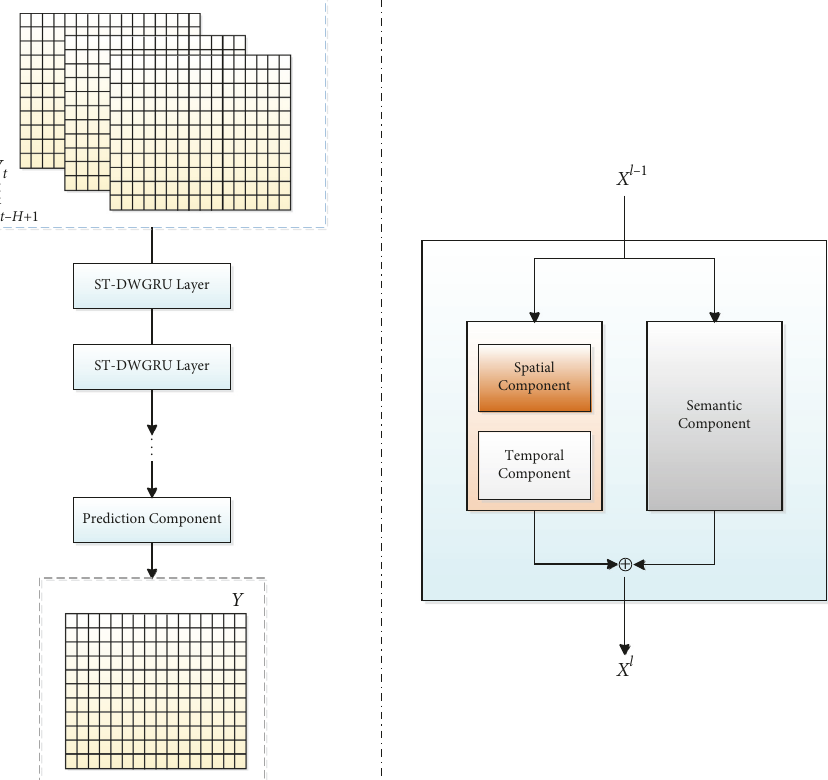
Y is the prediction. The right image is an ST- t is the traffic speed data and